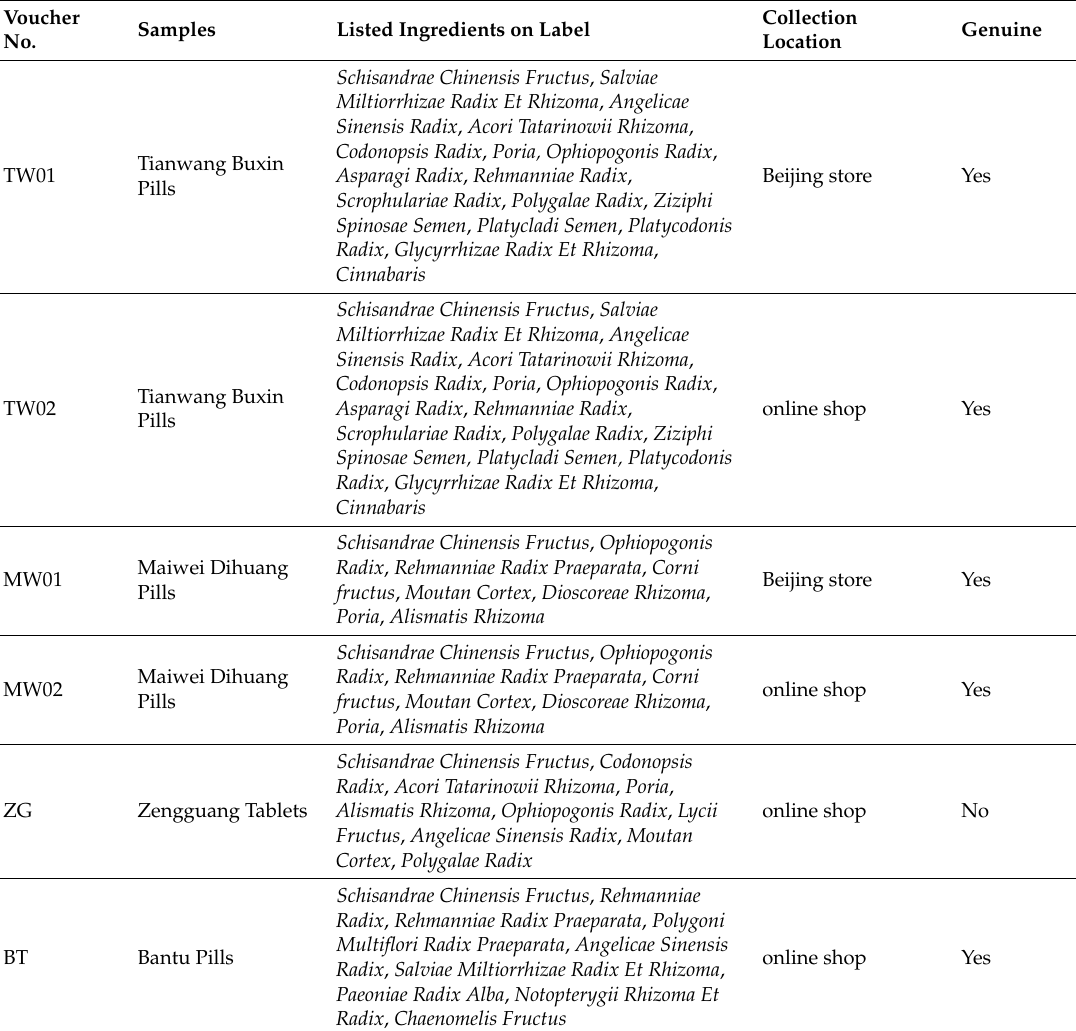
Table 2. Characteristics of eight Chinese patent medicines. Listed Ingredients on